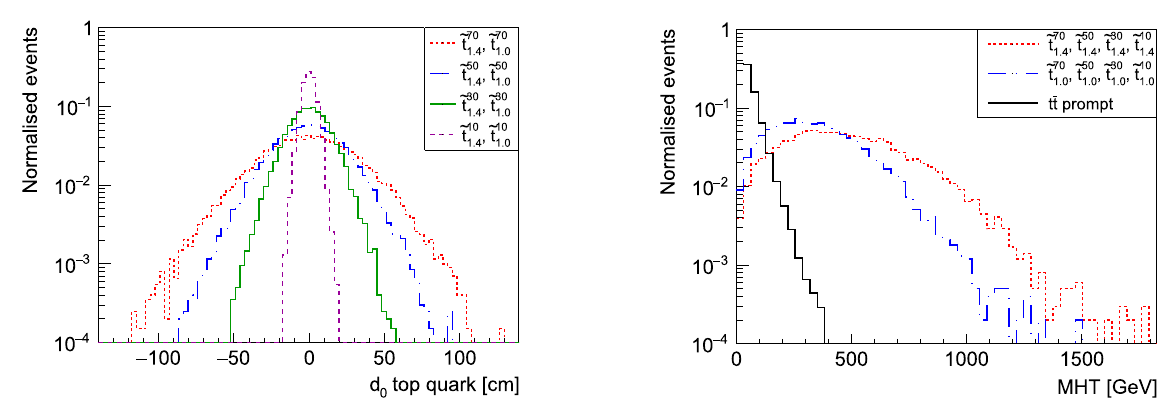
Fig. 53 Missing transverse hadronic energy MHT in the stop squark ˜ t case